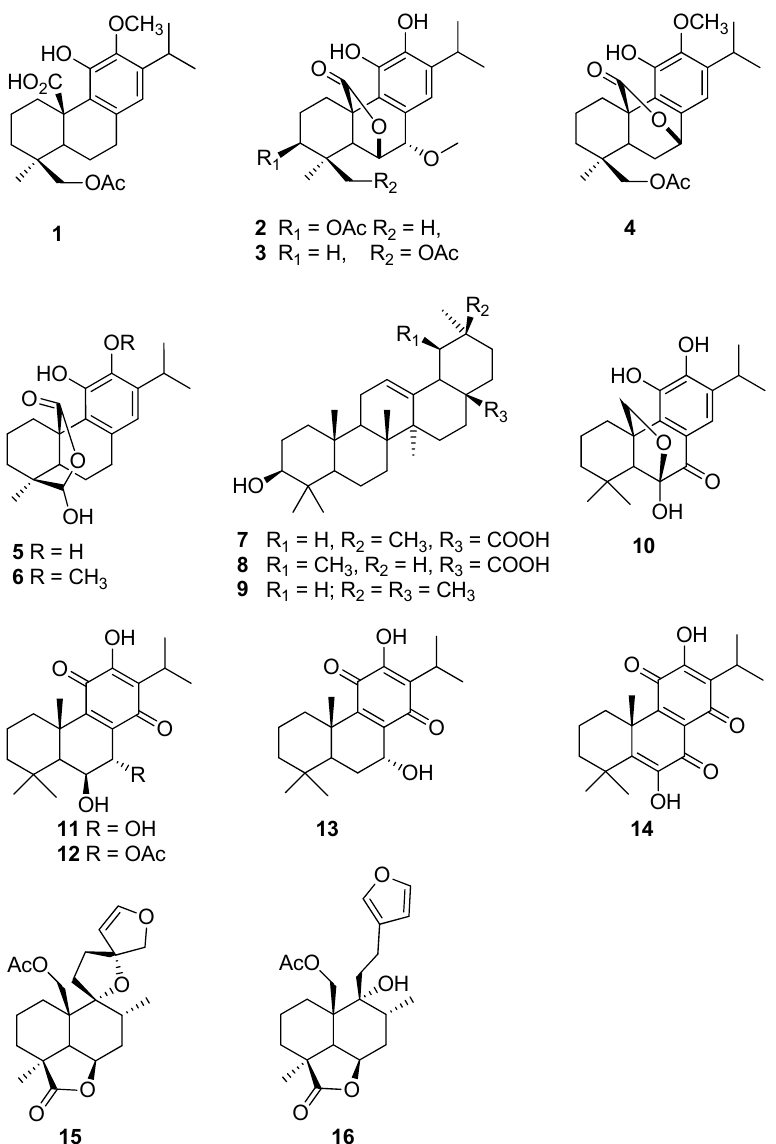
Figure 1. Chemical structures of the isolated compounds.